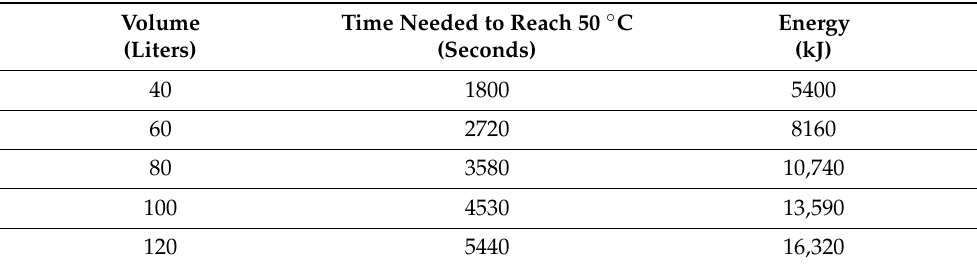
Figure 4. Temporal variation of water temperature for different tank capacities at a constant area. Table 4. Energy consumption for different tank